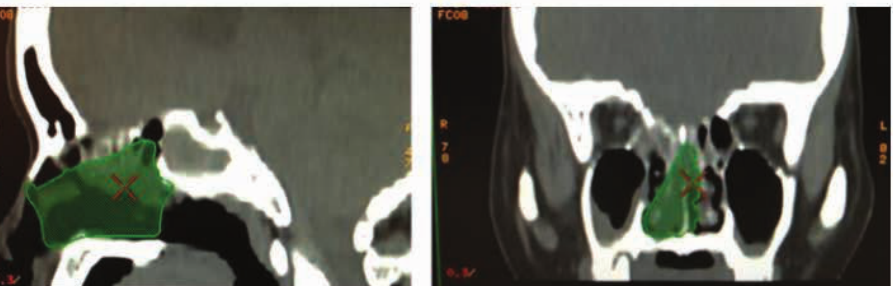
Figure 3: Images relevant to the linear distance between the anterior nasal spine and the anterior clinoid process for the ETT approach. Table 2: Mean volumes of the right and left nasal cavities and sphenoid sinuses relative to the mean distances between the anterior nasal spine (ANS) and sellar region by sex.